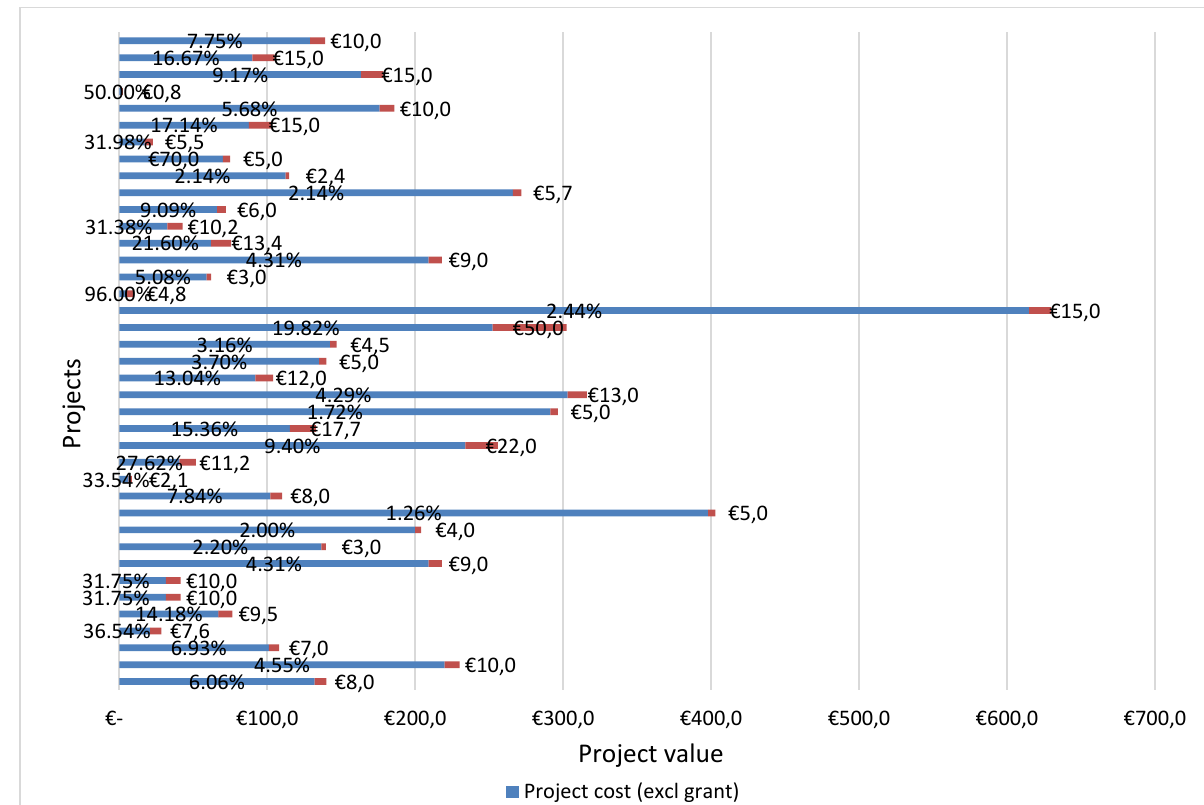
Figure 3. Proportion of grant cost per total project cost of the EU-supported project